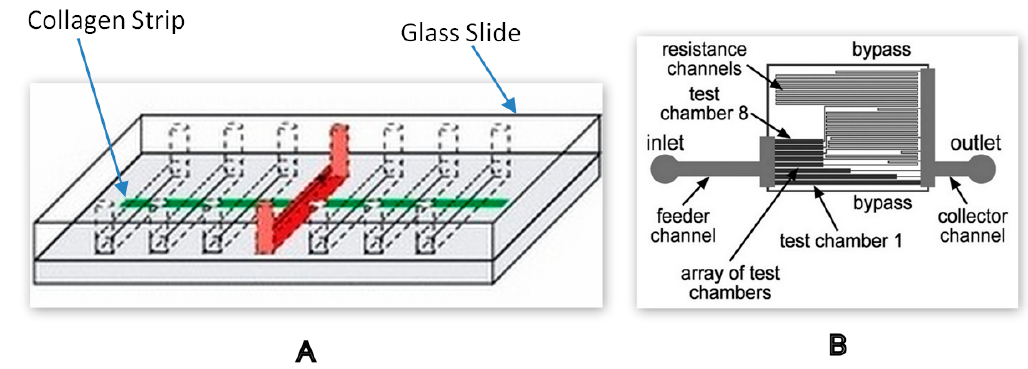
Figure 5. A . Microfluidic device with 13 channels mounted on a glass slide patterned with a collagen strip [40]. B . Schematic representation of a microfluidic device comprised of 8 parallel test chambers. Taken with permission from [12]. Taken with permission from